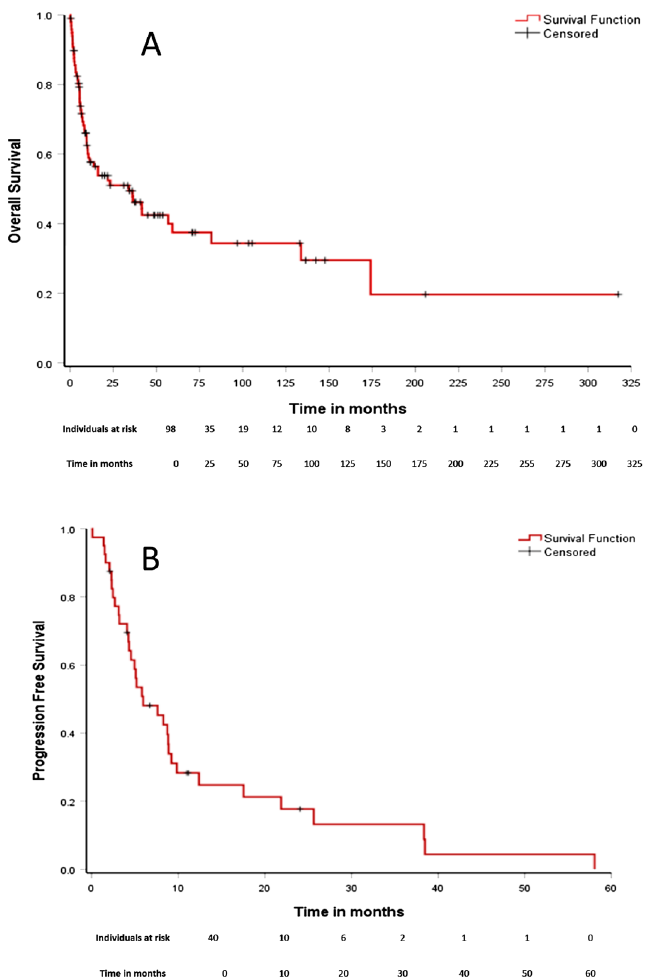
Figure 1. OS ( A ) e PFS ( B ) curves for 98 Brazilian patients with ENKTL.